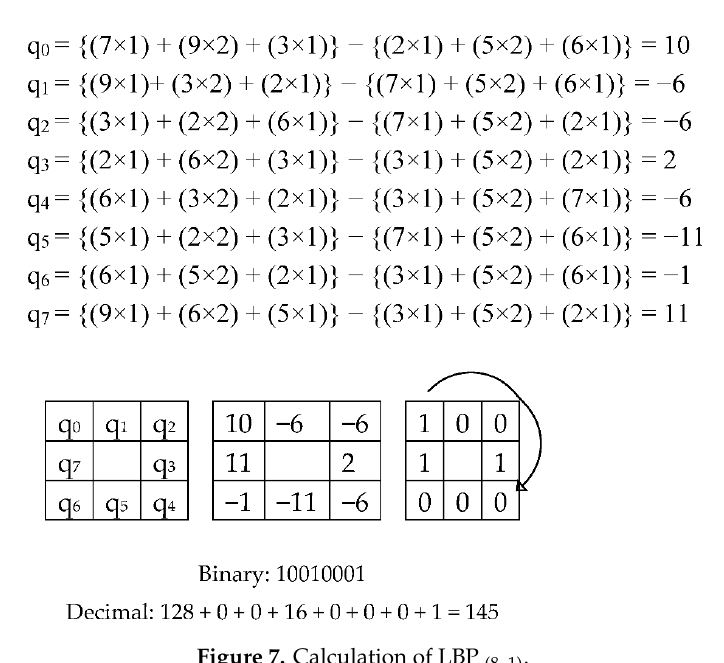
Figure 6. ( a ) Sample image segment of 3 × 3, ( b ) Description of Local Binary Pattern (LBP) (8, 1) : kernel value.